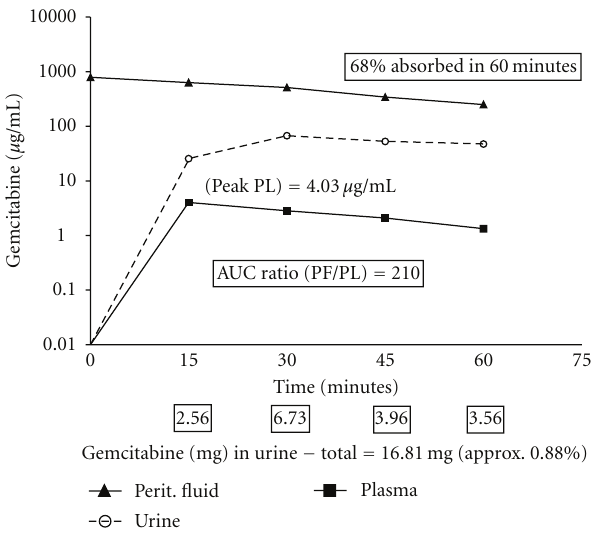
Figure 2: Pharmacology of intraoperative intraperitoneal gemc- itabine in a patient with resected pancreas cancer. The drug was used at 1,000 mg/m 2 in 3 liters of 1.5% dextrose peritoneal dialysis solution administered intraperitoneally. The area under the curve ratio of concentration × time intraperitoneal to intravenous was 210. Sixty-eight percent of the drug was cleared from the peritoneal cavity in 60 minutes. Data were taken from the study of a single patient but are similar to those in four other patients. The patient has completed the long-term intraperitoneal gemcitabine without